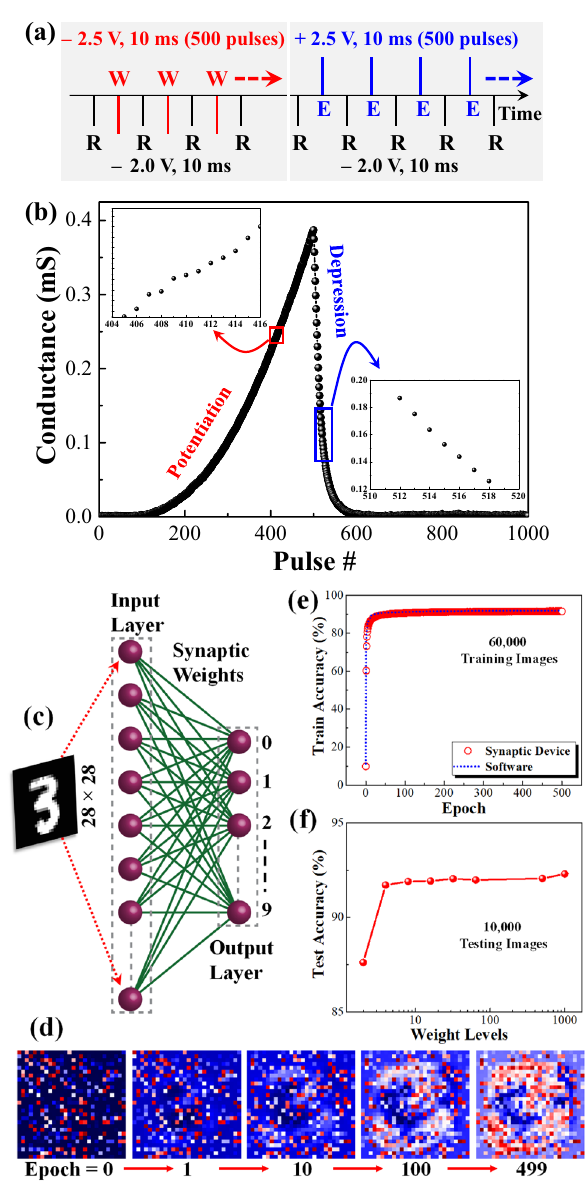
Figure 6. ( a ) Pulsing scheme to demonstrate the excitatory postsynaptic current (EPSC) and inhibitory postsynaptic current (IPSC) response based potentiation (P) and depression (D) of synaptic weight by applying 500 consecutive write (W) pulses (− 2.5 V, 10 ms) and erase (E) pulses (+ 2.5 V, 10 ms), respectively. A read pulse (− 2.0 V, 10 ms) is used to record synaptic weight change after every set of W/E pulses. ( b ) Potentiation and depression curve of synaptic weight change. Insets illustrate enlarged marked areas to visualize discrete conducting states during potentiation and depression. ( c ) Schematic of a single layer neural network used for MNIST pattern recognition. ( d ) Selected weight evolution mapping images from the output neurons layer corresponding to class “3” at different epochs starting from 0 to 499. ( e ) Training accuracy (%) vs number of epochs for both software and actual synaptic device based weight distribution. ( d ) Test accuracy (%) variation with the number or strength of device weight